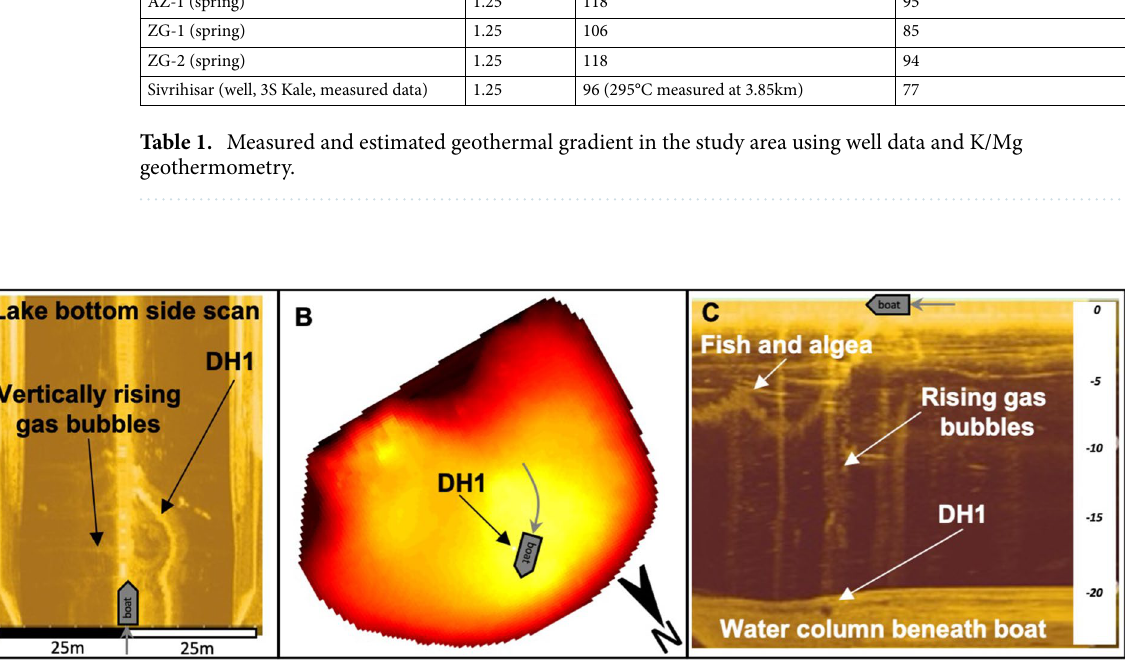
Figure 2. Sonar side scan images from the deep hole DH1, ( A ) Lake bottom in top view from the boat with a side-scan swath of 25 m. ( B ) Track of the boat. ( C ) Water column in profile view beneath the boat above deep hole DH1 with rising gas